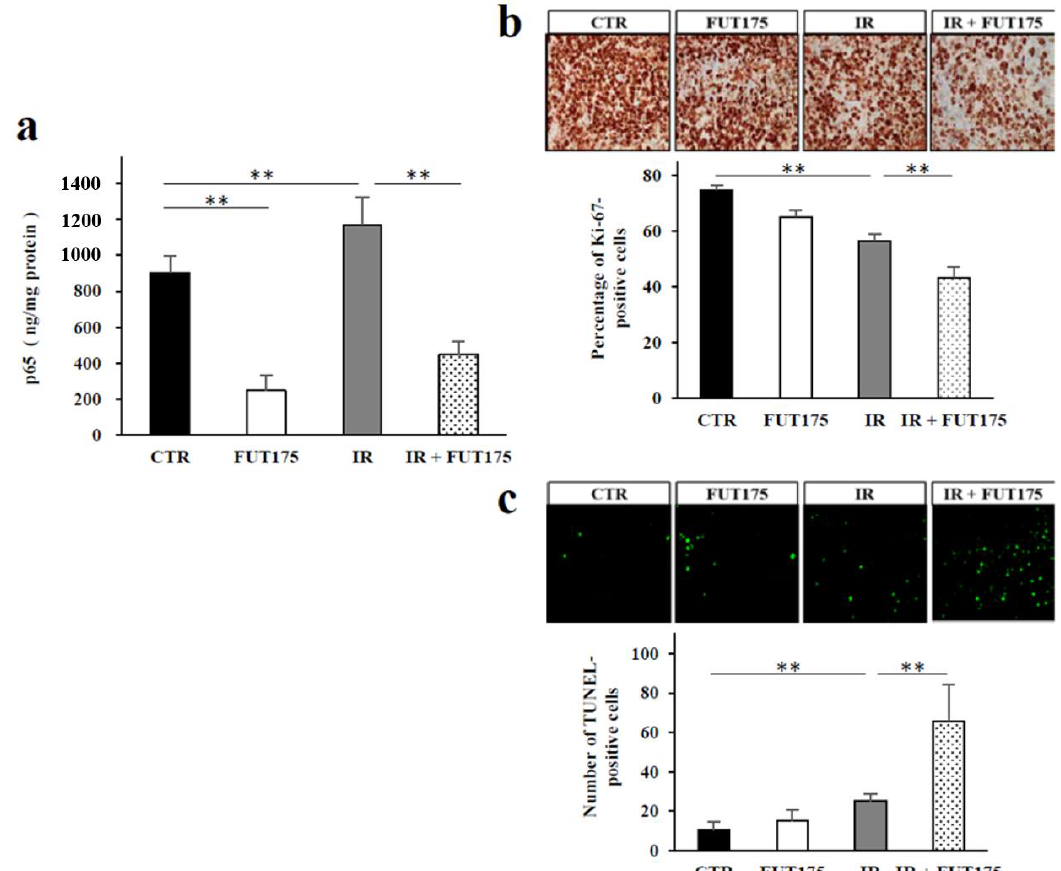
Figure 4. Nuclear factor kappa B (NF- κ B) activity and immunohistochemical analysis of cell proliferation and apoptosis in vivo. ( a ) ELISA revealed that the concentration of NF- κ B p65 in the nuclear extract of excised tumor tissues in the ionizing radiation (IR) group was significantly higher than that in the control group, and the IR-induced NF- κ B activation was inhibited in the combination group ( p < 0.01). ( b ) The percent of Ki-67-positive cells in the combination group was lower than that in the IR group (43.3% ± 3.9 vs. 56.5% ± 2.6, p < 0.01). ( c ) The number of TdT-mediated dUTP nick-end labeling (TUNEL)-positive cells in the combination group was higher than that in the IR group (65.7% ± 18.3% vs. 25.2 ± 3.6, p < 0.01). **, p < 0.01.